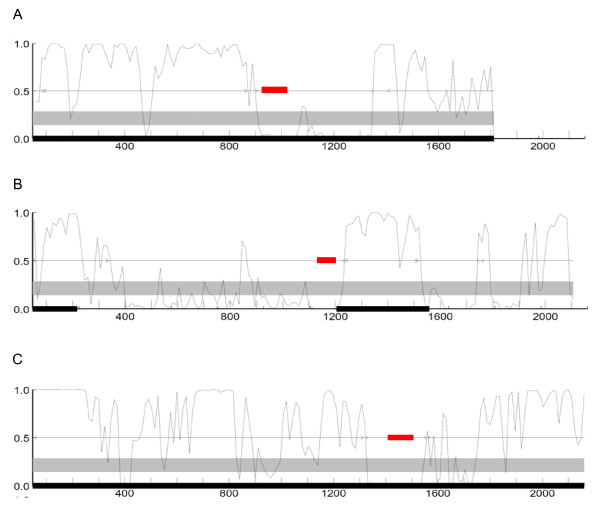
Coding probability of genes with Alu-derived exons. GeneMark protein coding probability analyses are shown for three genes with well-characterized Alu-derived exons: C-rel-2 [CCDS: CCDS1864.1] (A) MTO1-3 [CCDS: CCDS4979.1] (B) and PKP2b-4 [CCDS: CCDS8731.1] (C) [41]. Coding probabilities were calculated within windows sliding along the length of the genes. The locations of the Alu-derived exons are shown in red.